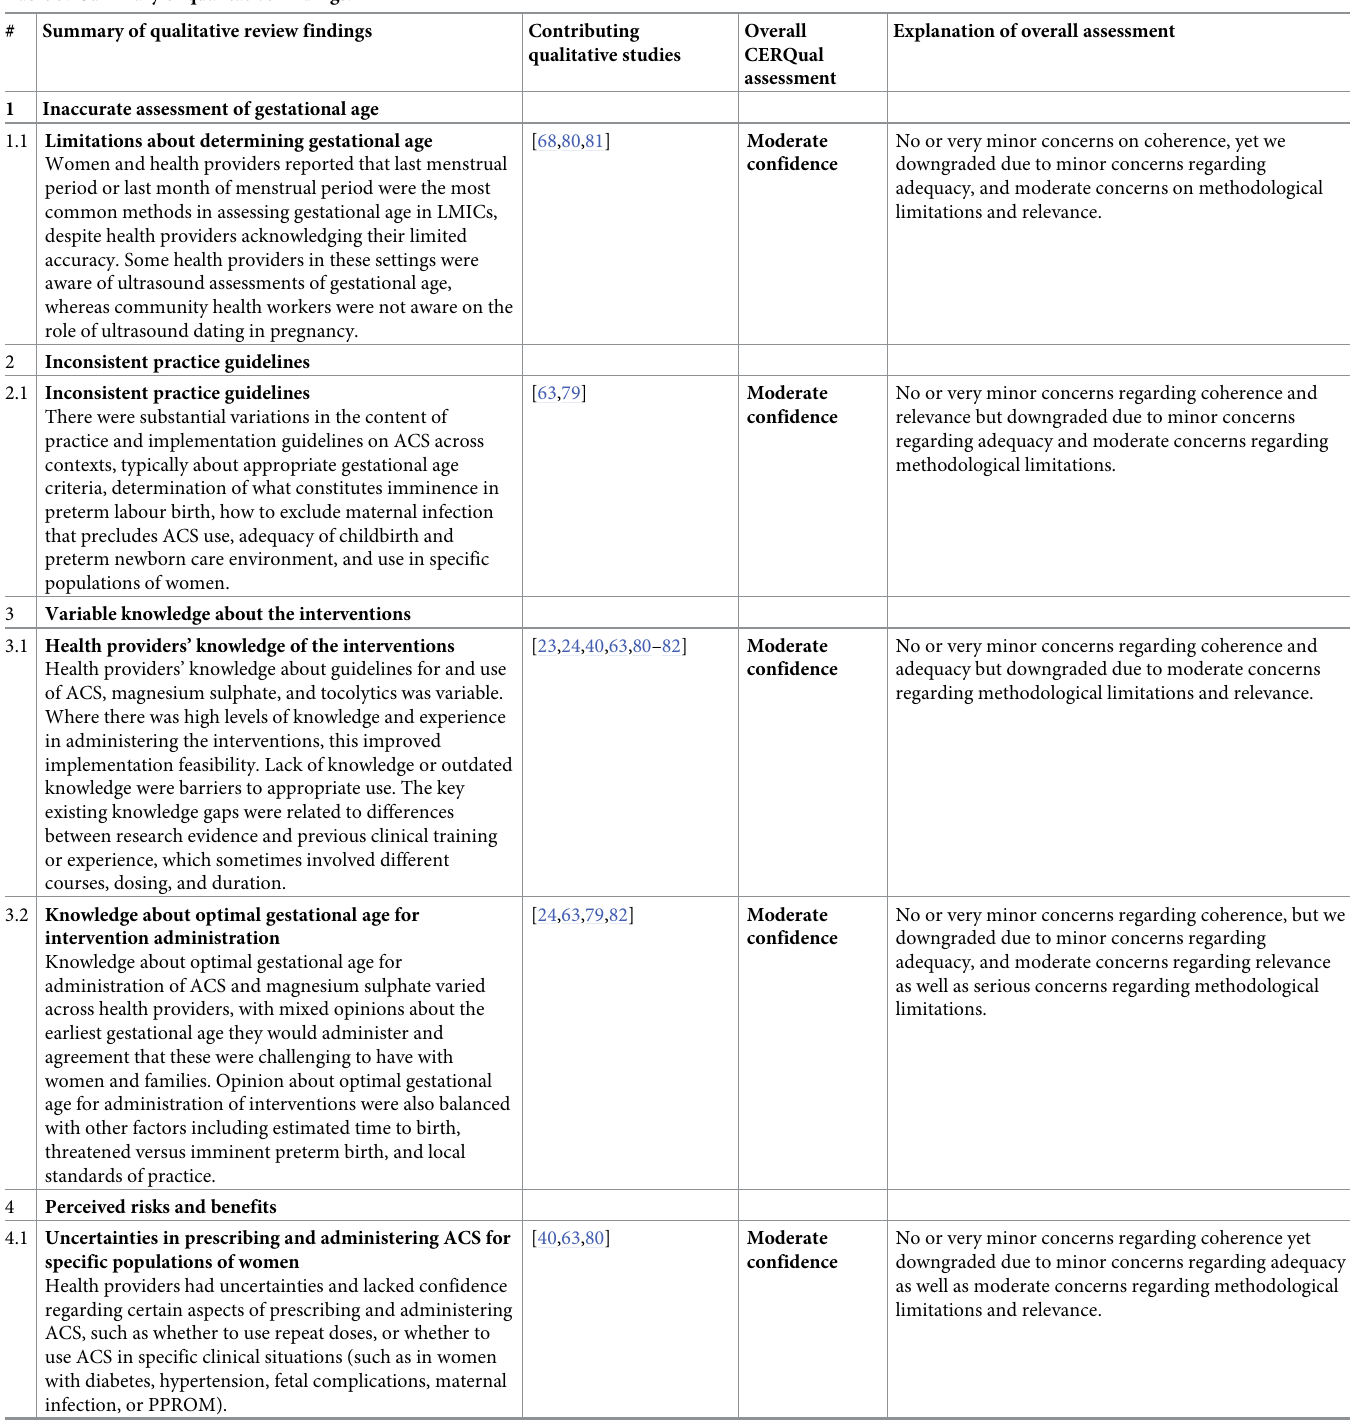
Table 3. Summary of qualitative